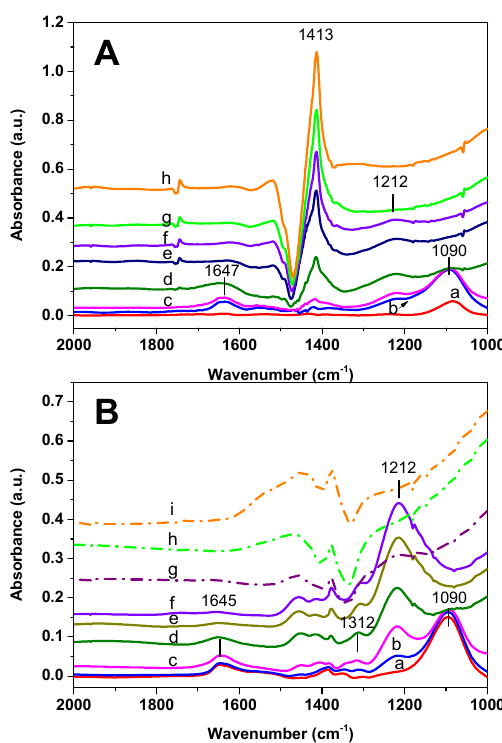
Figure 6. Operando FT ‐ IR spectra during NO/NH 3 –TPR with NO (1000 ppm) + NH 3 (1000 ppm) from 40–400 °C (4 °C/min) over ( A ) Rh ‐ BaO/Al 2 O 3 at: ( a ) 40 °C with NH 3 ; ( b ) 40 °C with NH 3 +NO; ( c ) 40 °C before temperature ramp; ( d ) 50 °C; ( e ) 104 °C; ( f ) 260 °C; ( g ) 292 °C; ( h ) 400 °C. Panel ( B ) Pt ‐ BaO/Al 2 O 3 at: ( a ) 40 °C with only NH 3 ; ( b ) 40 °C NH 3 + NO; ( c ) 40 °C before temperature ramp; ( d ) 104 °C; ( e ) 153 °C; ( f ) 178 °C; ( g ) 203 °C; ( h ) 328 °C; ( i ) 400 °C (rig#3).